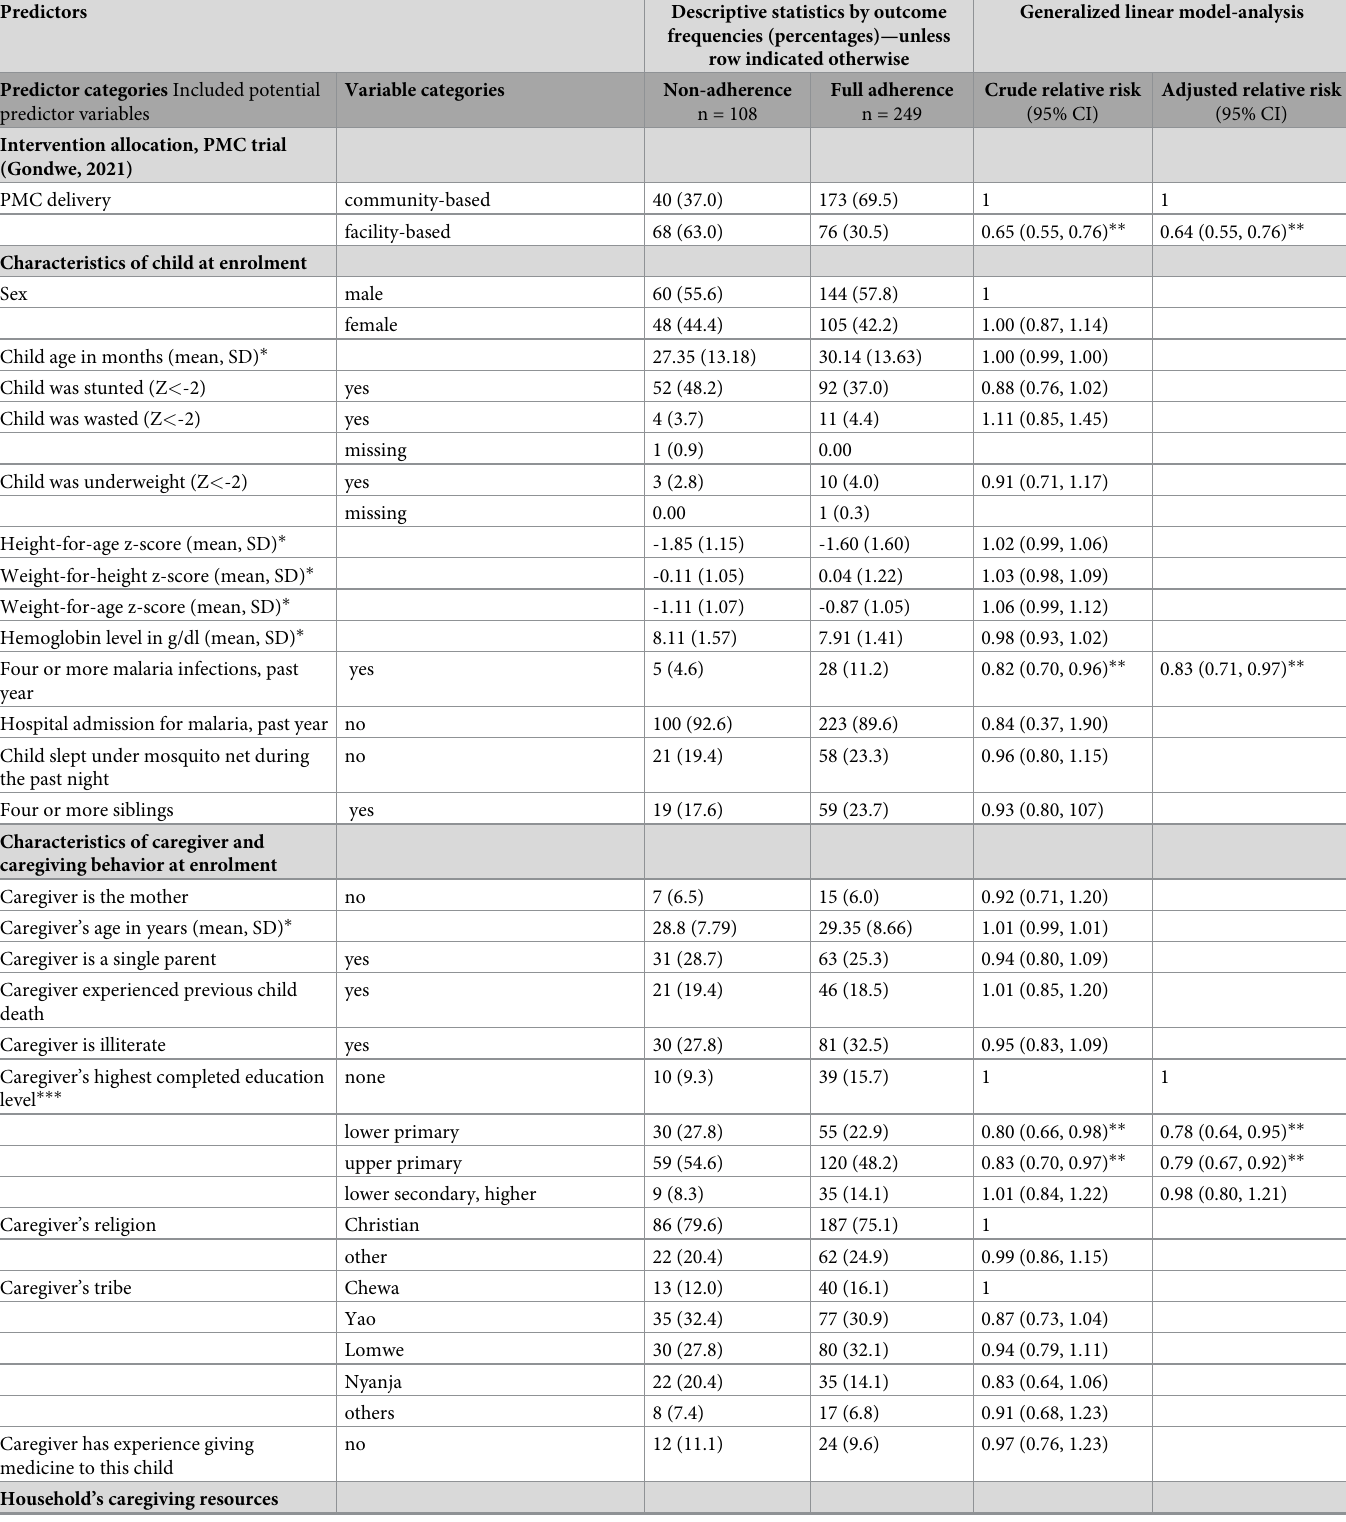
Table 1. Descriptive statistics and regression analysis of potential predictors for adherence to